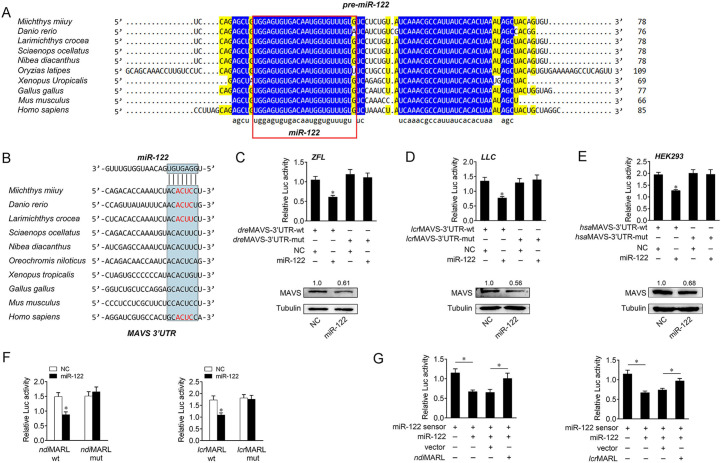
The ceRNA network of regulating MAVS is widely found in other species.(A) Sequence alignment of pre–miR-122 from various vertebrate species. Mature miR-122 sequences are shown in boxes. (B) Putative miR-122-binding site of MAVS 3’UTR among different vertebrate species. (C) miR-122 target D. rerio MAVS 3’UTR and regulates its expression. ZFL cells were transfected with NC or miR-122, along with the wild-type of D. rerio MAVS 3’UTR (dreMAVS-3’UTR-wt) or the mutant-type (dreMAVS-3’UTR-mut). The luciferase activity was measured and normalized to renilla luciferase activity (upper panel). ZFL cells were transfected with NC or miR-122 for 48 h. MAVS expression were analyzed by western blotting (lower panel). (D) miR-122 target L. crocea MAVS 3’UTR and regulates its expression. LLC cells were transfected with NC or miR-122, along with the wild-type of L.crocea MAVS-3’UTR (lcrMAVS-3’UTR-wt) or the mutant-type (lcrMAVS-3’UTR-mut). The luciferase activity was measured and normalized to renilla luciferase activity (upper panel). LLC cells were transfected with NC or miR-122 for 48 h. MAVS expression were analyzed by western blotting (lower panel). (E) miR-122 target H. Sapiens MAVS 3’UTR and regulates its expression. HEK293 cells were transfected with NC or miR-122, along with the wild-type of H. sapiens MAVS-3’UTR (hsaMAVS-3’UTR-wt) or the mutant-type (hsaMAVS-3’UTR-mut). The luciferase activity was measured and normalized to renilla luciferase activity (upper panel). HEK293 cells were transfected with NC or miR-122 for 48 h. MAVS expression were analyzed by western blotting (lower panel). (F) The finding that miR-122 regulating the luciferase activity of MARL is also examined in N. diacanthus and L. crocea. NLC cells were transfected with NC or miR-122, together with the wild type or mutated type of N. diacanthus MARL, then luciferase activity was analyzed and normalized to renilla luciferase activity (left panel). LLC cells were transfected with NC or miR-122, together with the wild type or mutated type of as well as L. crocea MARL, then luciferase activity was analyzed and normalized to renilla luciferase activity (right panel). (G) MARL reduces miR-122 activity in N. diacanthus and L. crocea. NLC cells or LLC cells were respectively transfected with N. diacanthus or L. crocea MARL expression plasmid, together with miR-122 sensor, miR-122 and pcDNA3.1 vector for 48 h. The luciferase activity was analyzed and normalized to renilla luciferase activity. All data represented the mean ± SE from three independent triplicated experiments. *, p < 0.05.